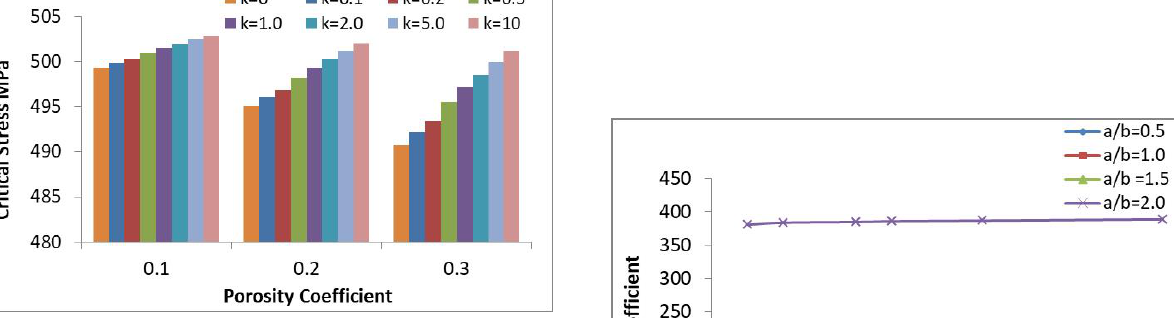
Fig. 4. The critical stress with PEEK -30% CF core, ( a / h =20, a / b =1), and height of skins 2.5 mm.